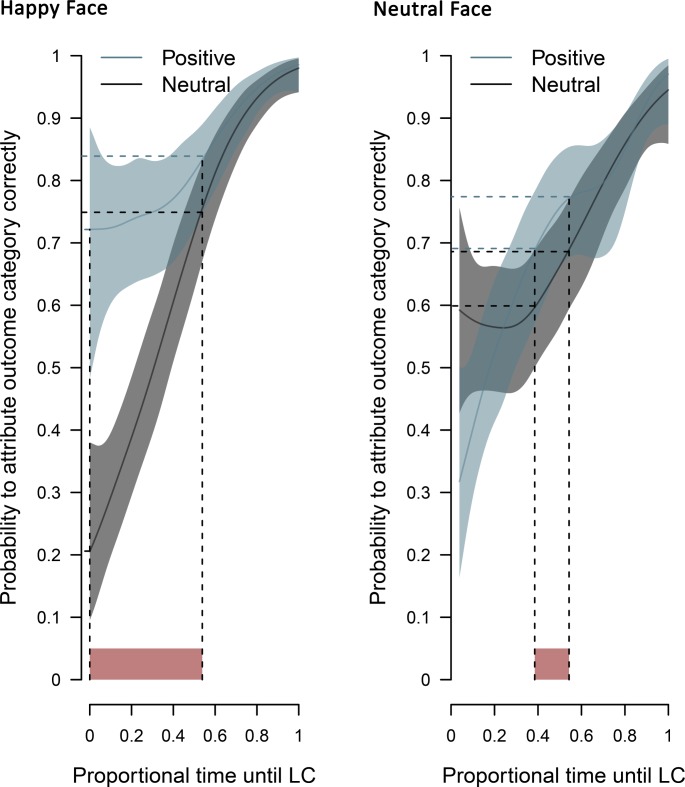
Learning curves.Posteriori mean probabilities to attribute the outcome category correctly during the learning phase (illustrated by horizontal dashed lines) at the lower and upper bounds of the time intervals until the learning criterion was met (illustrated by red areas).